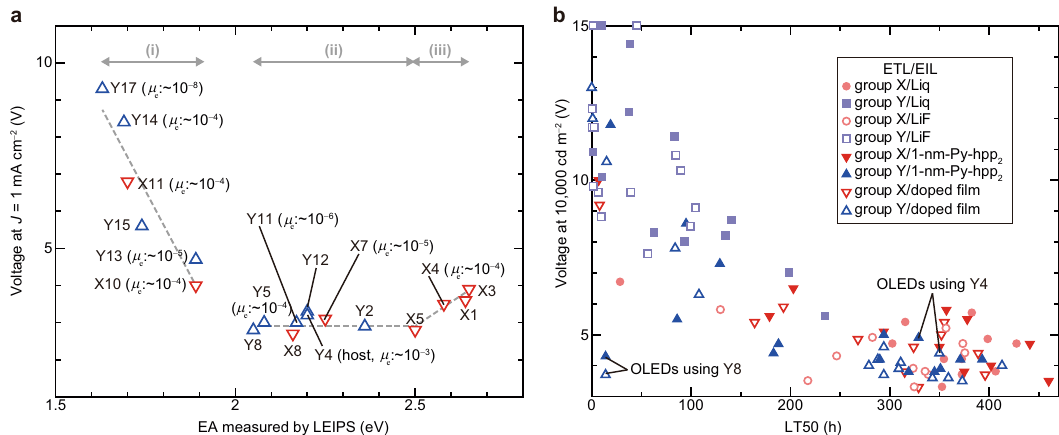
Fig. 3 Quantitative analysis of OLED characteristics. a Summary of correlation between actual EA of materials used as ETL (horizontal axis) and operating voltage of OLEDs with Py-hpp 2 -doped fi lm at J of 1 mA cm − 2 (vertical axis). The electron mobility ( μ e ) of some materials is also shown. b Summary of correlation between operational lifetime (LT50) (horizontal axis) and operating voltage of OLEDs at luminance of 10,000cd m − 2 (vertical axis). LT50 is the time for the luminance to decay by 50% from 10,000 cd m − 2 .